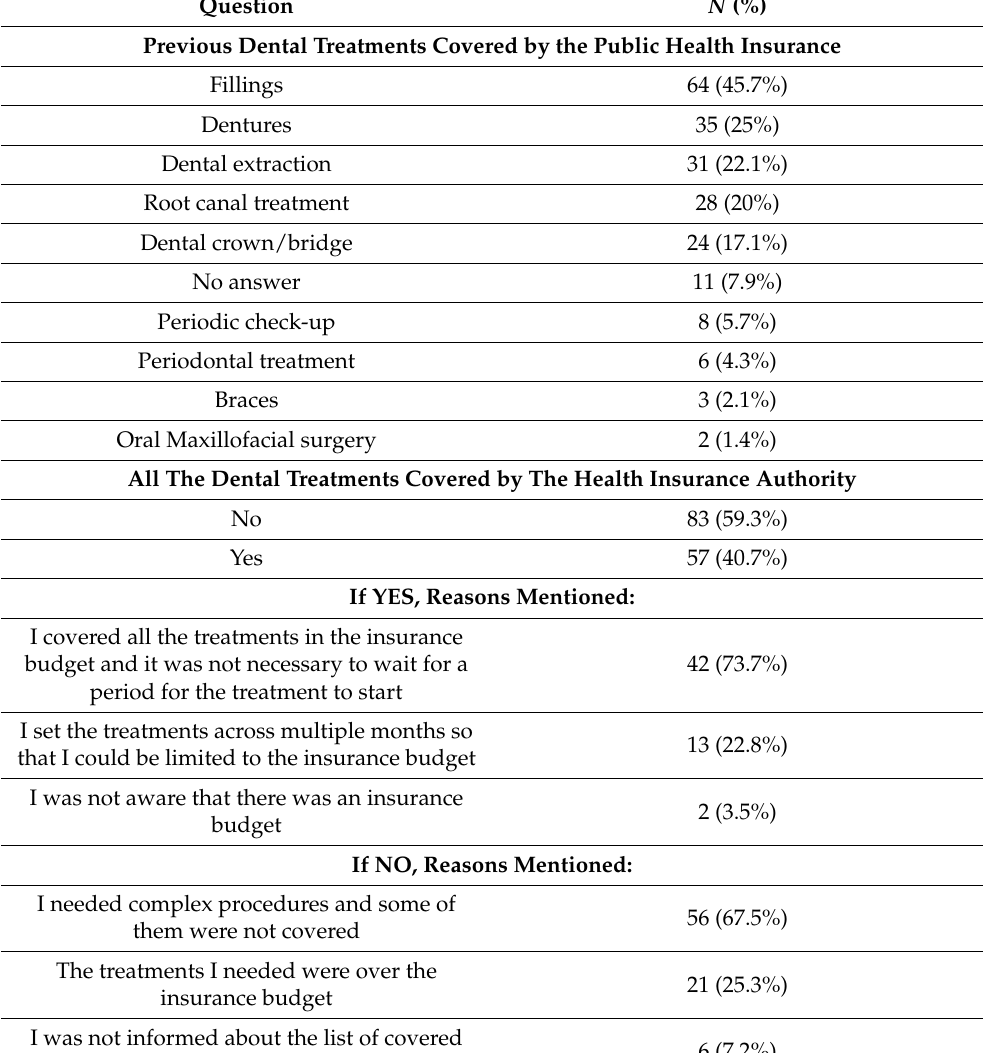
Table 3. Patients’ history of dental treatments using public health